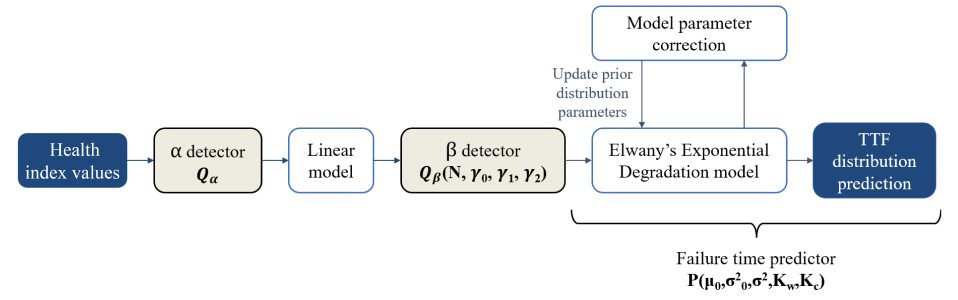
Figure 2. Framework of a multi-state health model M ( Q α , Q β , P )